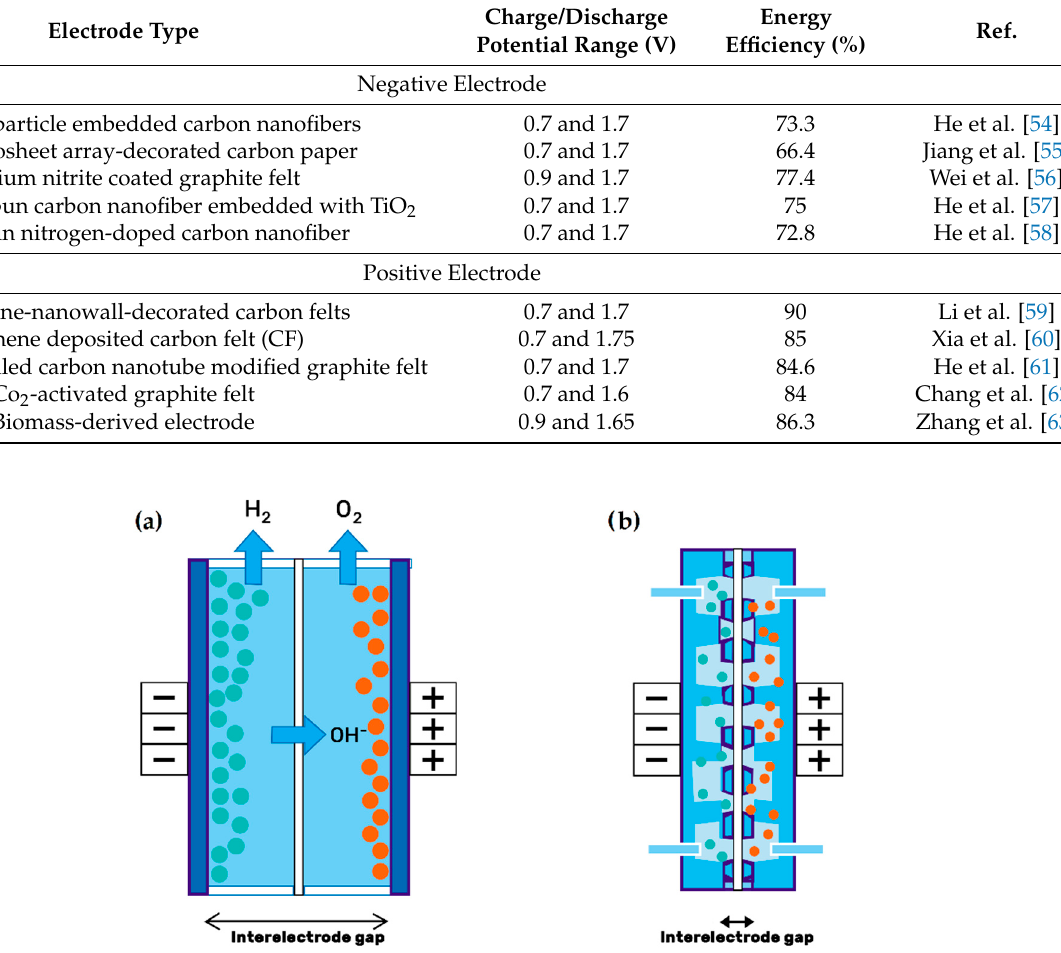
8 of 20 Table 3. Electrodes used as negative and positive electrode components.